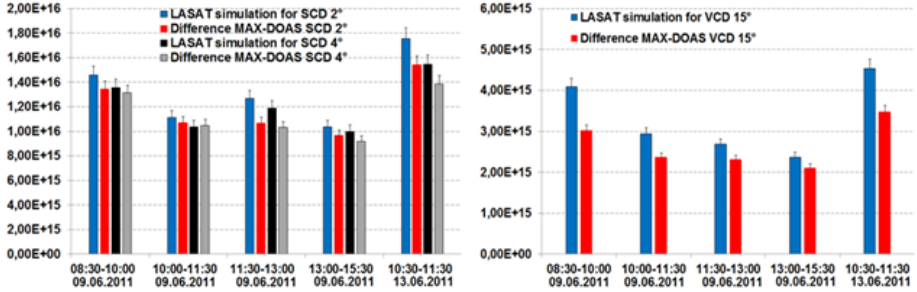
Figure 8. Simulated SCDs vs. SCDs measured by MAX-DOAS (a) and simulated VCDs vs. VCDs measured by MAX-DOAS (b) on 9 and 13 June, 2011 at Milan oasis. SCDs were measured and simulated for elevation angles of 2 and 4 ◦ ; VCDs were measured at 15 ◦